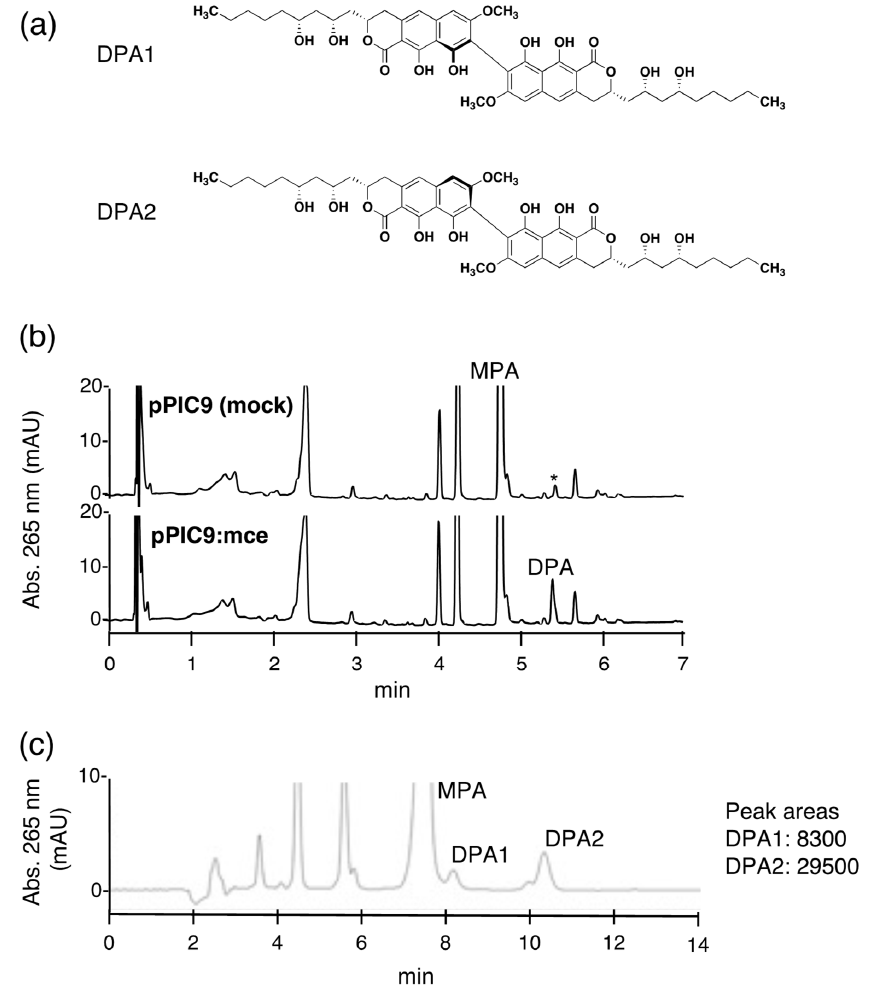
Figure 1. The activity of MCE produced in P. pastoris . ( a ) Structures of DPA1 and DPA2. ( b ) The MCE activity of the culture supernatant from P. pastoris transformed by pPIC9(mock) (upper panel) and pPIC9:mce (lower panel). Twenty microliters of culture supernatant were used for analysis of the MCE reaction, and the reaction products were analyzed by UFLC equipped with an ODS column. * Background peak coming from the culture supernatant was observed close to DPA. ( c ) Analysis of the amounts of the atropisomers DPA1 and DPA2. The MCE reaction product in the supernatant of the pPIC9:mce transformants was analyzed by HPLC equipped with a C-30